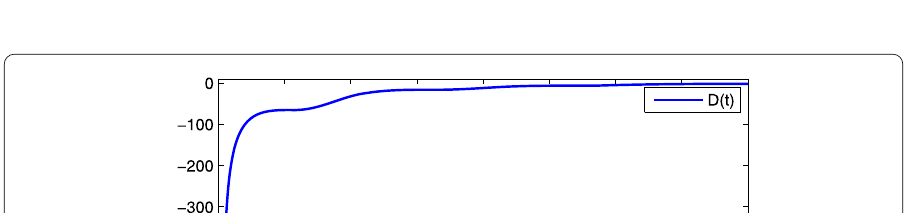
Figure 5 The trajectory of H ( t ) in Example 4.4